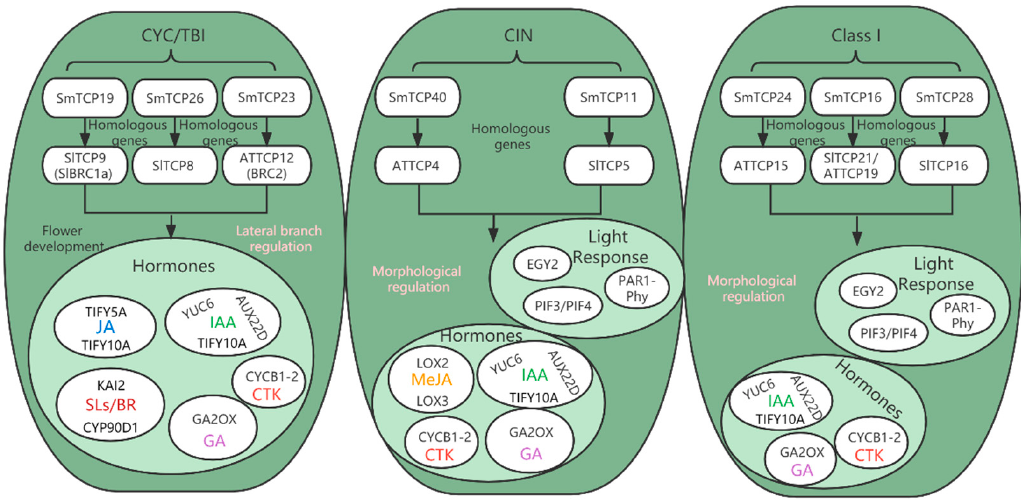
Figure 11. Summary of regulatory mechanisms of CYC/TBI, CIN, Class I.